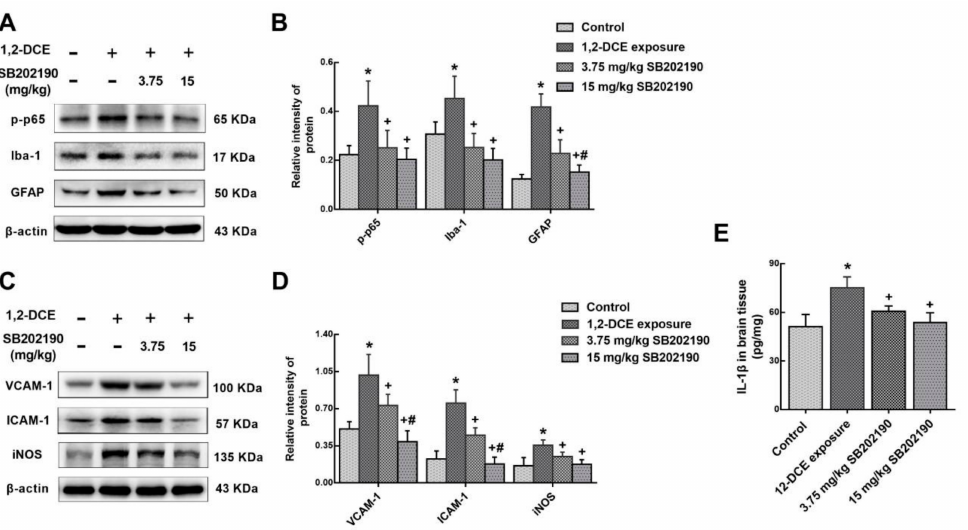
Figure 6. Involvement of p38 in upregulation of p-p65, Iba-1, GFAP, VCAM-1, ICAM-1, iNOS, and IL-1 β expression in 1,2-DCE-intoxicated mice. ( A , C ) Representative images of Western blot analysis. ( B , D ) Graphs show the densitometric quantitation of p-p65, Iba-1, GFAP, VCAM-1, ICAM-1, and iNOS, which were normalized to the intensity of β -actin. ( E ) IL-1 β expression levels in the brain tissues measured by ELISA. Data expressed as mean ± SD are the results of five independent experiments and analyzed by One-way ANOVA. Significant di ff erence is defined as p < 0.05, and *, vs. control group; + , vs. 1,2-DCE poisoned group; # vs. low dose intervention